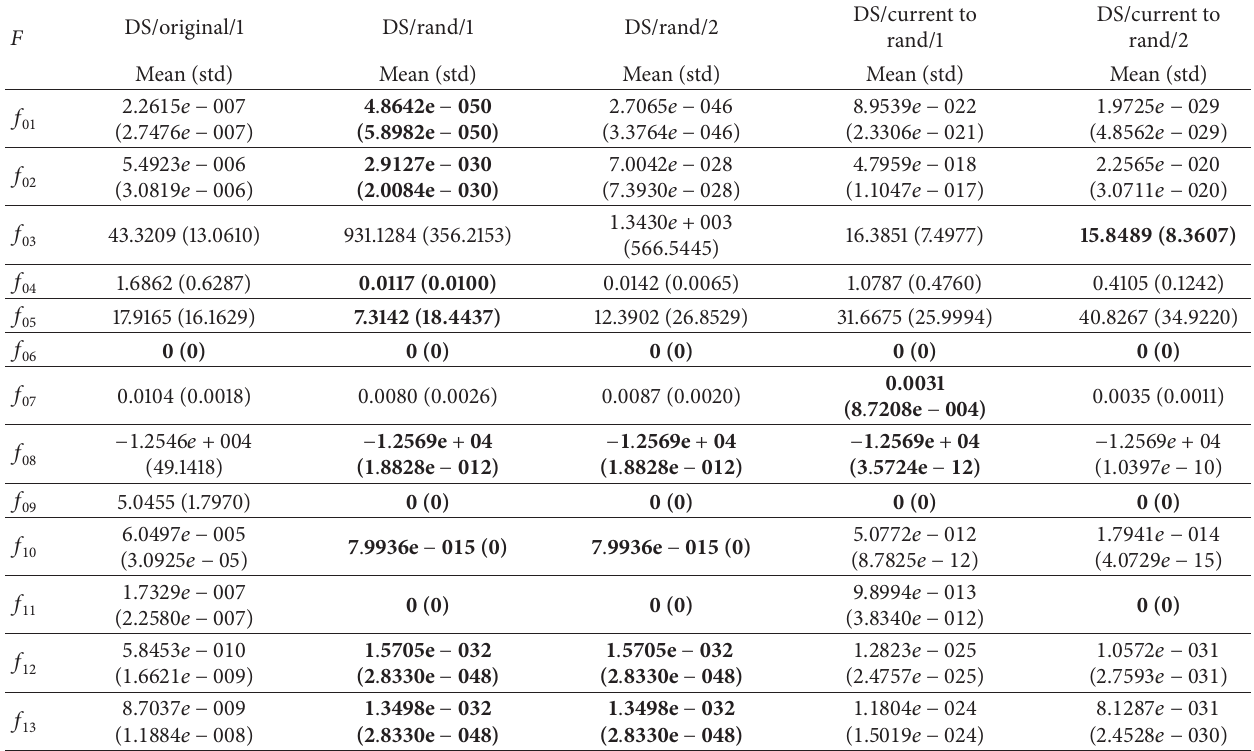
Table 4: Comparisons of different schemes for 30 𝐷